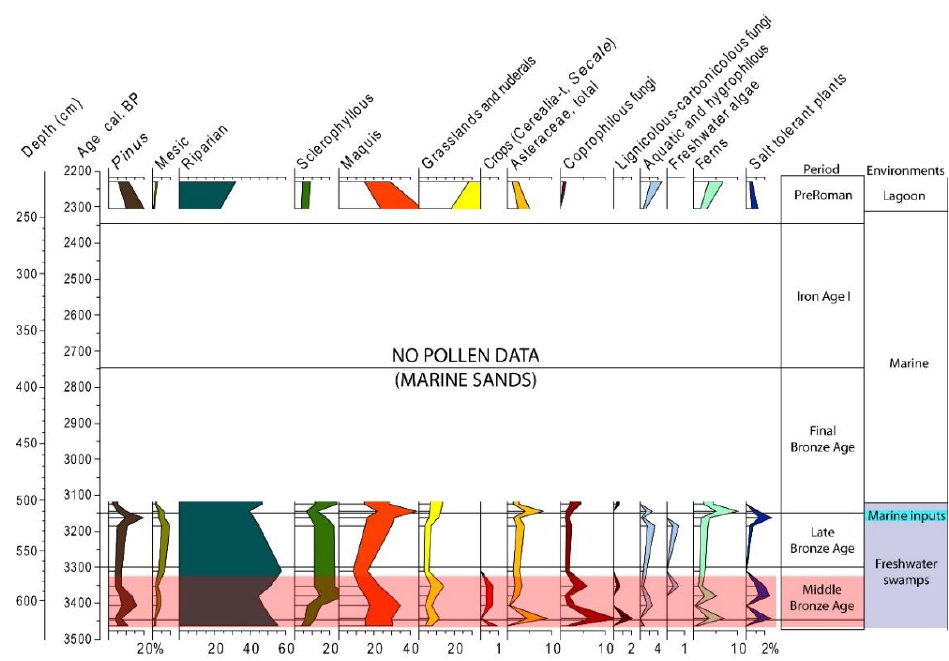
Figure 6. Synthetic pollen diagram reconstructed for the Lower Sagone Valley.